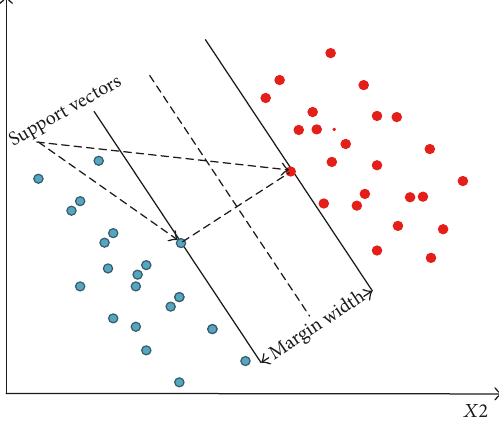
Figure 7: Linear support vector machine.